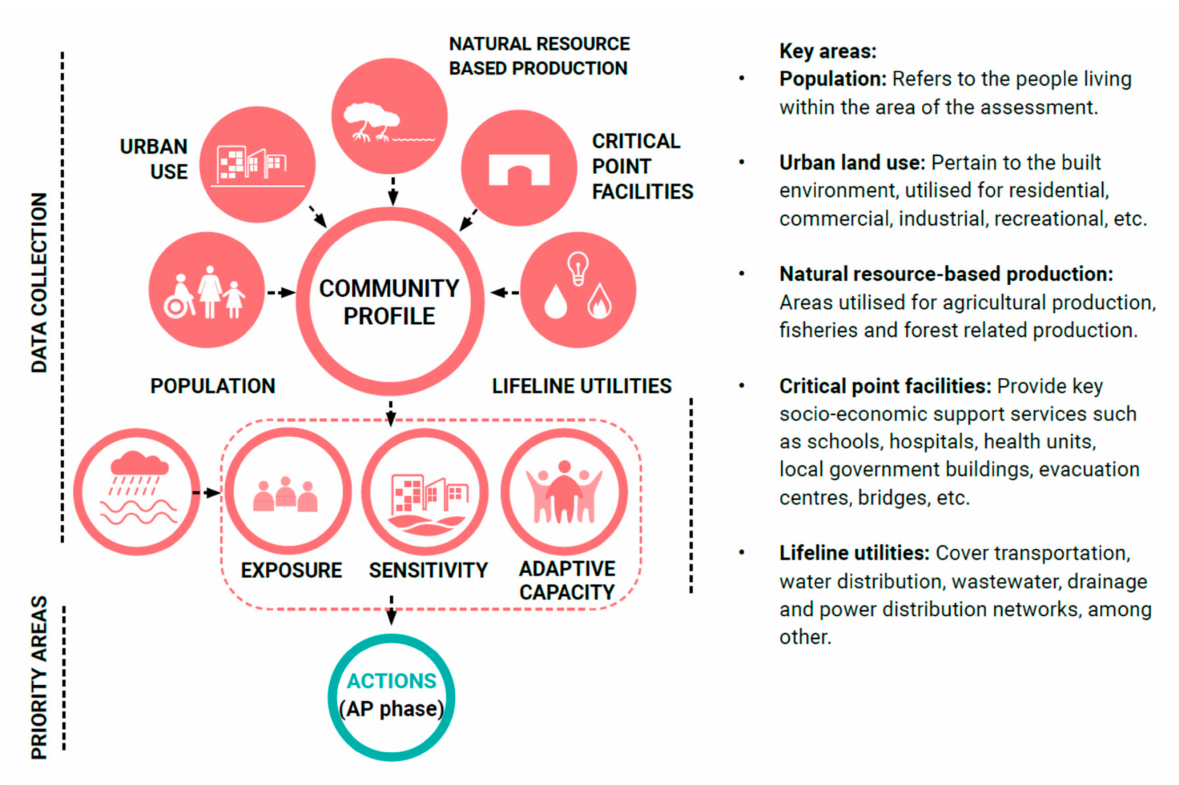
Figure 6. Vulnerability and risk assessment and action planning overview (Data from